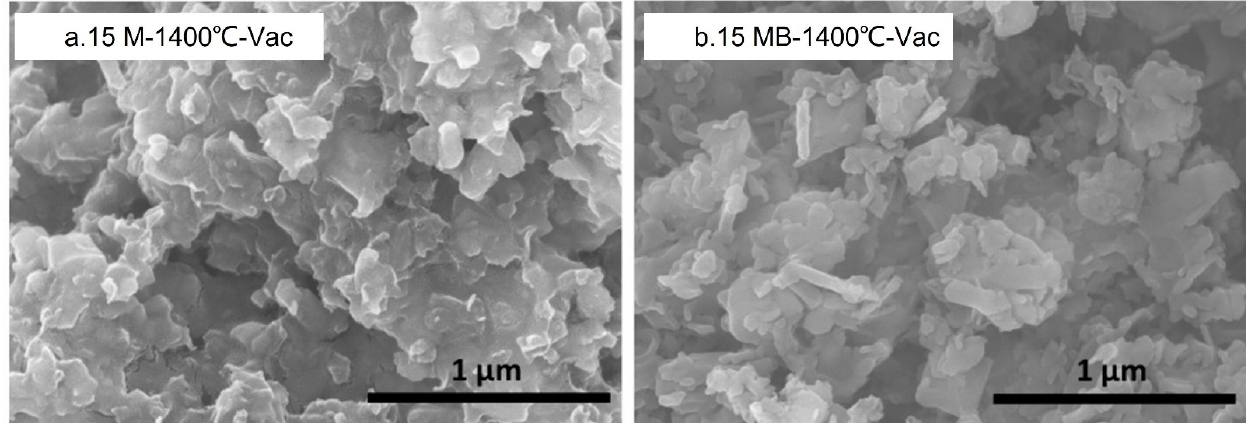
Figure 17. SEM diagrams of the vacuum treatment products of the two kinds of precursors ( a ) 15 MM and ( b ) 15 MB.